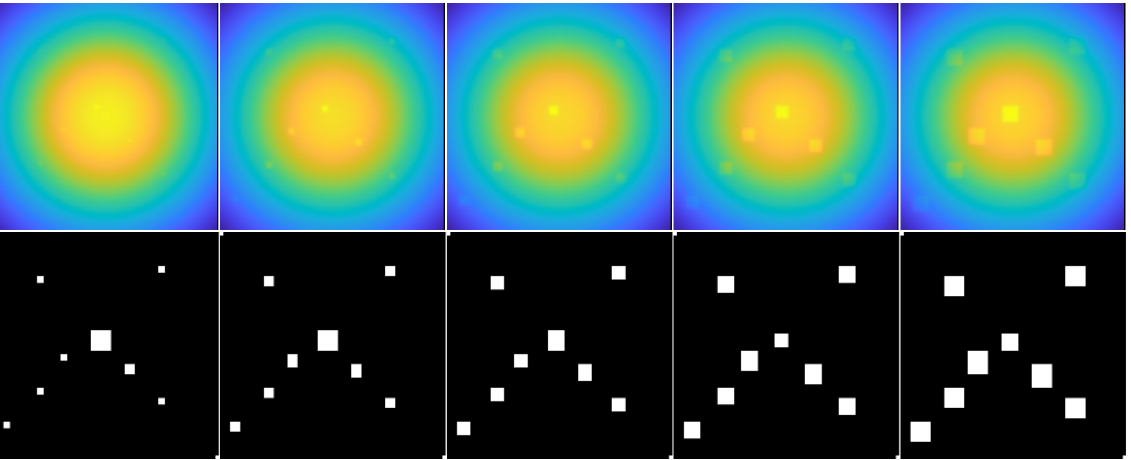
Figure 3. Automated defect detectionin simulated thermal sequence sum-type synthetic images. Lateral size ( S ) for ROI-d. Column No. 1: 3 mm, No. 2: 6 mm, No. 3: 9 mm, No. 4: 12 mm, and No. 5: 15 mm. Row No. 1: sum-type images, D = 1.0 mm. Row No. 2: resulting binary images.